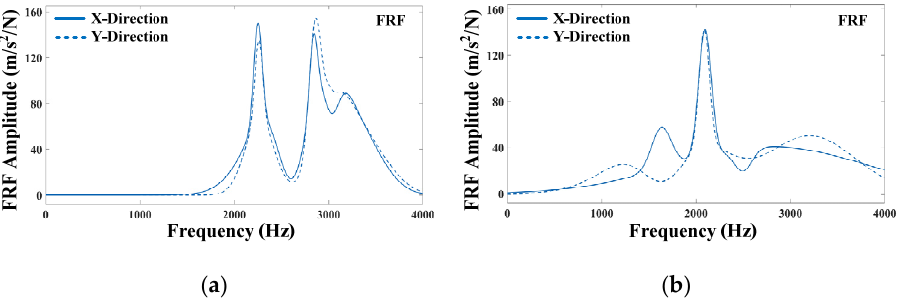
Figure 4. FRF of the tool-spindle system; ( a ) under the industrial conditions; ( b ) under the laboratory conditions.